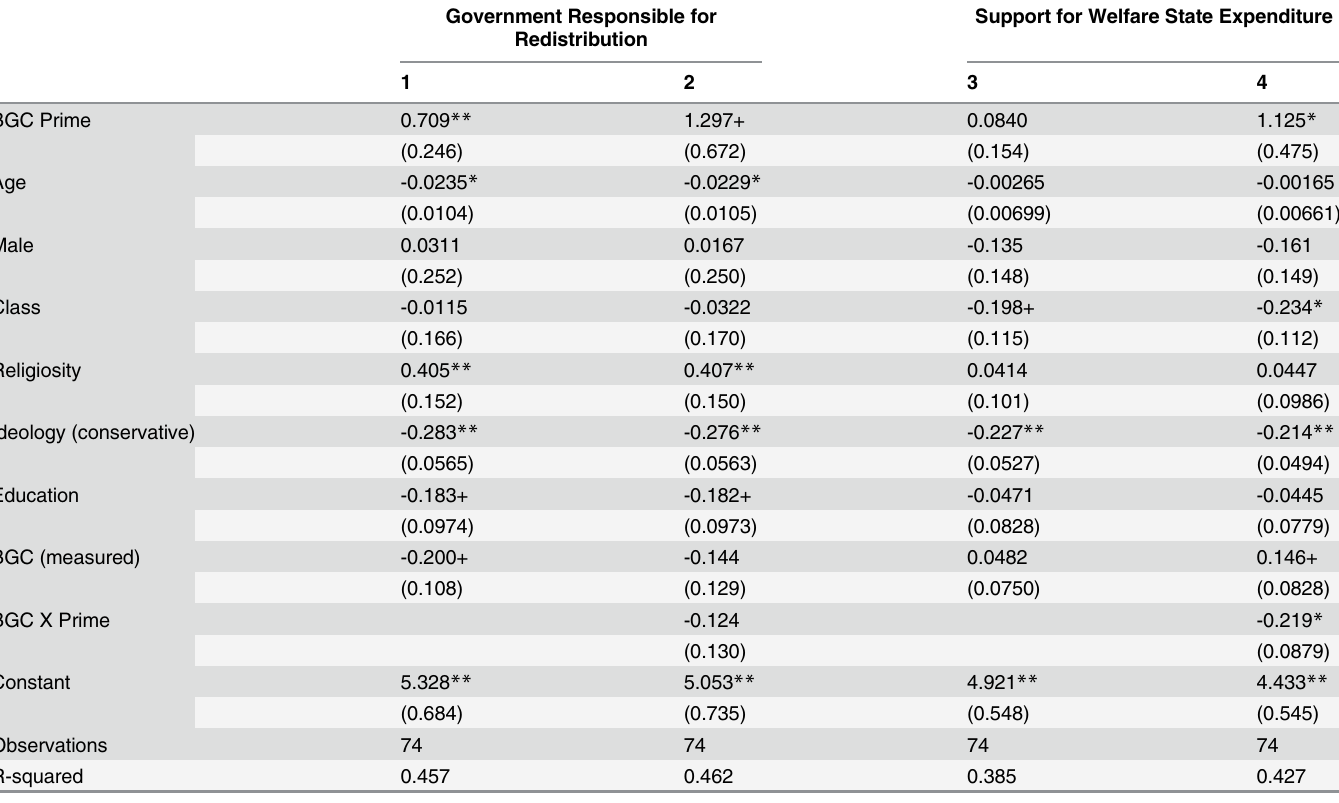
Table 6. Effect of BGC on WSA among American Catholics (Study 3, Catholic